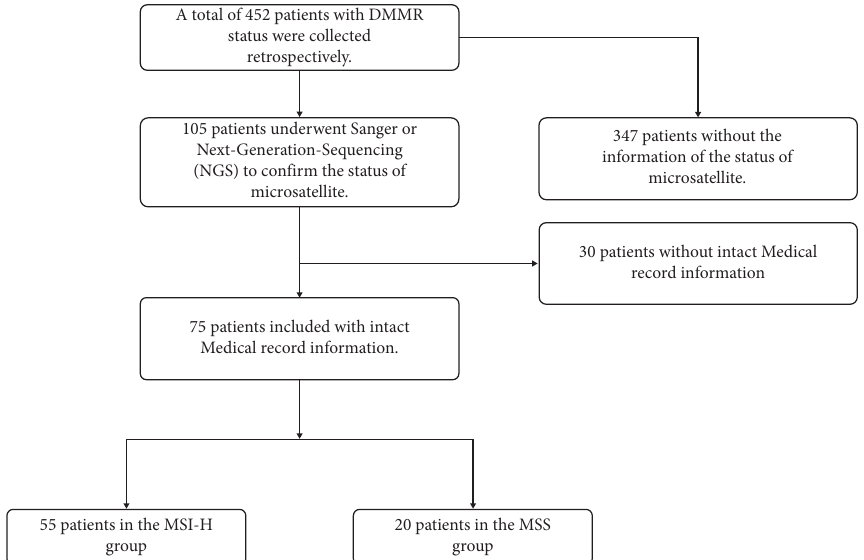
Figure 1: Flowchart of study selection.